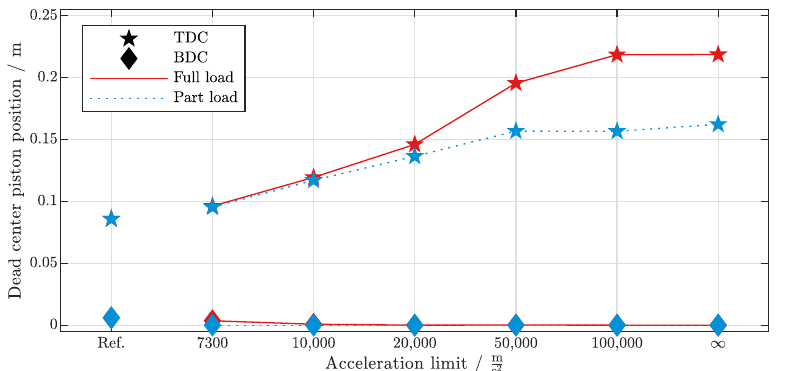
Figure 5. Evolution of the piston dead center positions for full and part load operation as a function of a maximum piston acceleration limit.